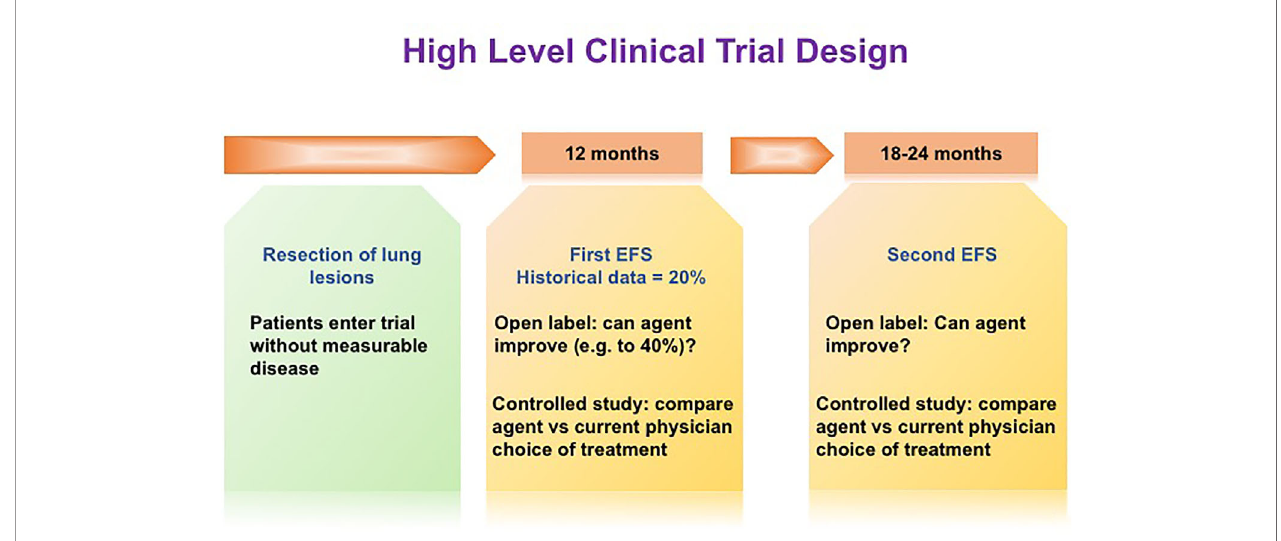
FIGURE 3 | High level clinical trial design. In order to increase the ability to observe clinical impacts of novel dormant DTCs-targeting drugs, novel trial endpoints may be required. We propose an innovative trial design, namely, improving EFS at a later time point, e.g. 6-12 months following the initial EFS at 12 months